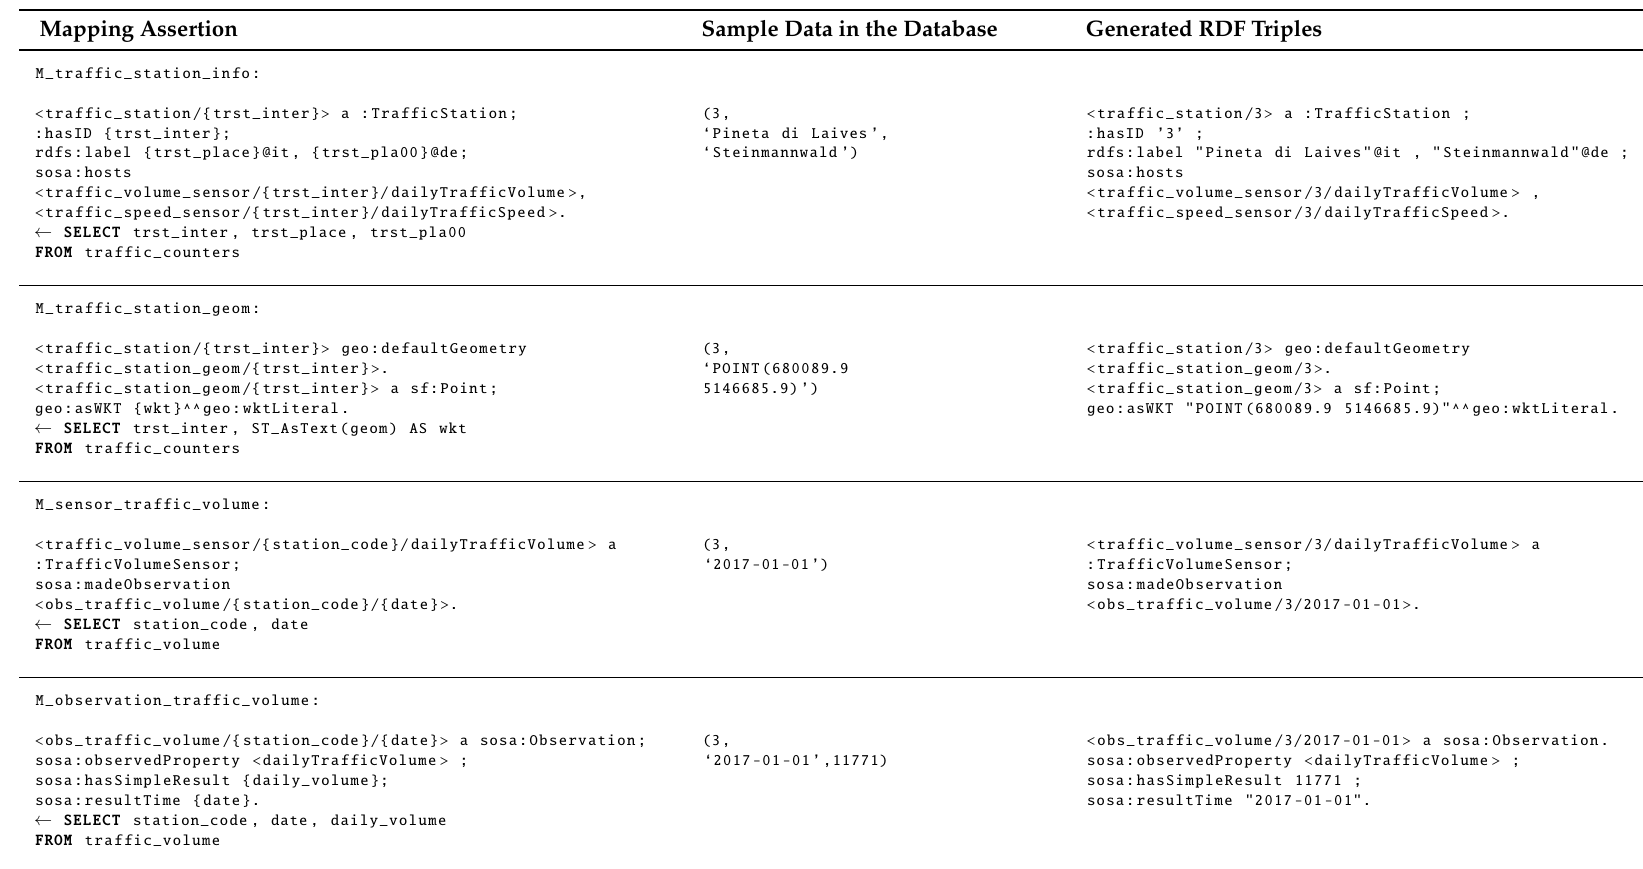
Table 3. Example mapping assertions (on traffic station, sensor, and observation), and generated Resource Description Framework (RDF)